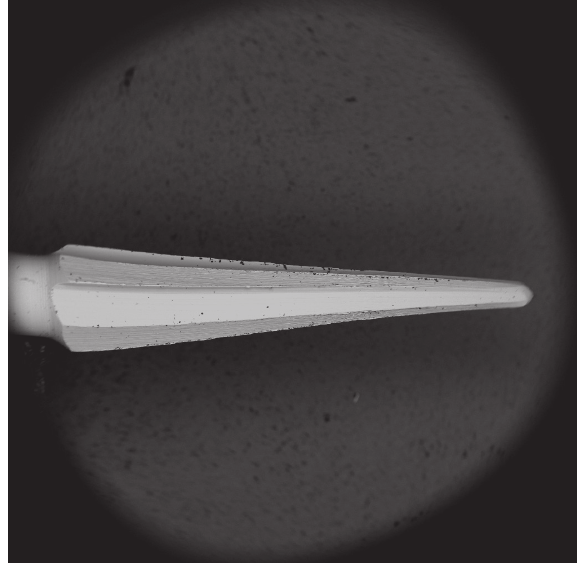
Figure 1- Scanning electron microscope photomicrograph (X10) showing the TripleGates